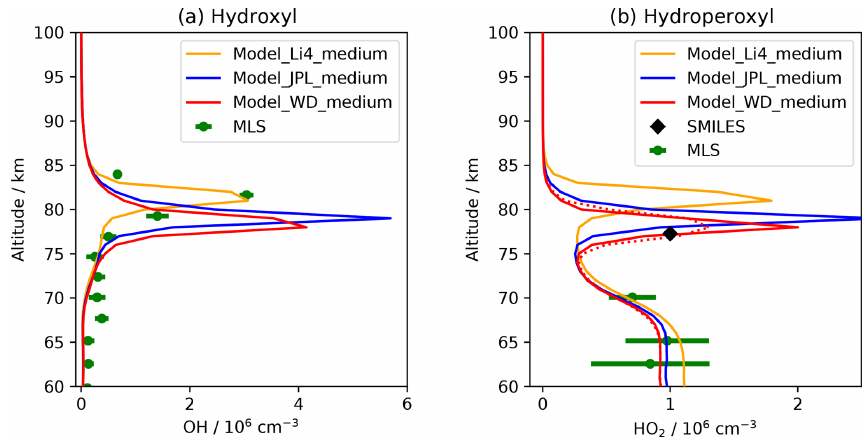
Figure 2. Modelled altitude profiles of (a) OH and (b) HO 2 number densities before the sprite event B in comparison with satellite data. The solid lines depict model profiles for 18 November 2009, 0:15LT, solar zenith angle 165.7 ◦ at 6.7 ◦ N, 79 ◦ W. Shown are results of three model simulations with different rate coefficients for some HO x reactions (see text for details). For all model runs, medium vertical transport velocities were used. Green data points depict MLS (Level 2, v04) zonally averaged night-time values for 18 November 2009 and latitudes 33 ◦ S–40 ◦ N; the mean solar zenith angle is 142 ◦ ; the error bars correspond to 1 standard deviation. The SMILES HO 2 data point corresponds to the atmospheric background value prior to the sprite event measured at 77km (Yamada et al., 2020). Corresponding to the vertical resolution of SMILES, the dotted red line shows a 3km running average of the red Model_WD profile.